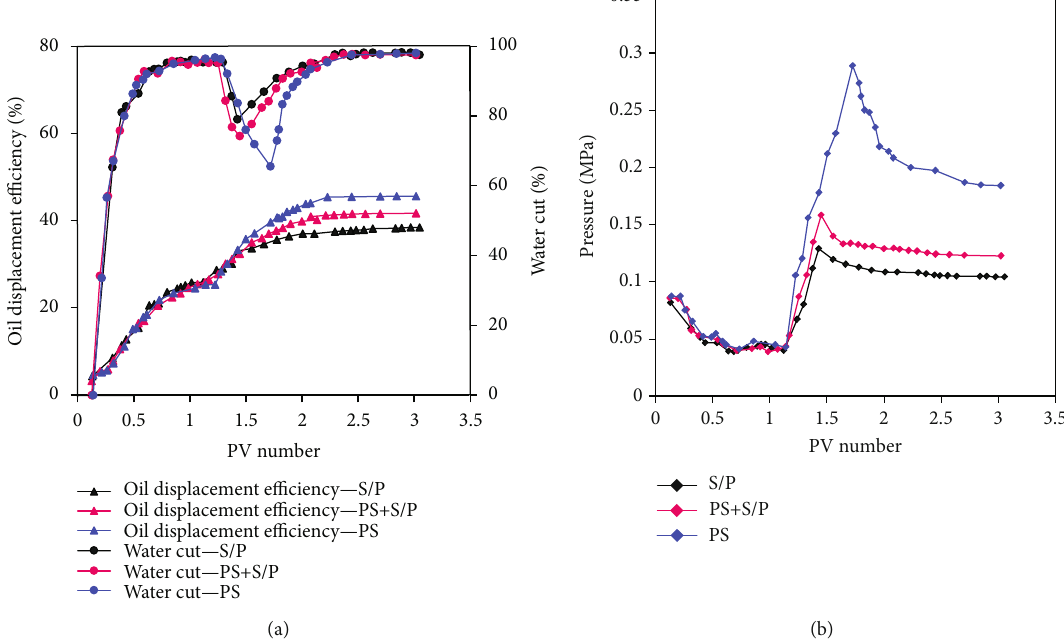
Figure 9: Curves of injection pore volume versus oil displacement e ffi ciency, water cut, and pressure with a permeability ratio of 6 for di ff erent oil displacement measures: (a) oil displacement e ffi ciency and water cut; (b)